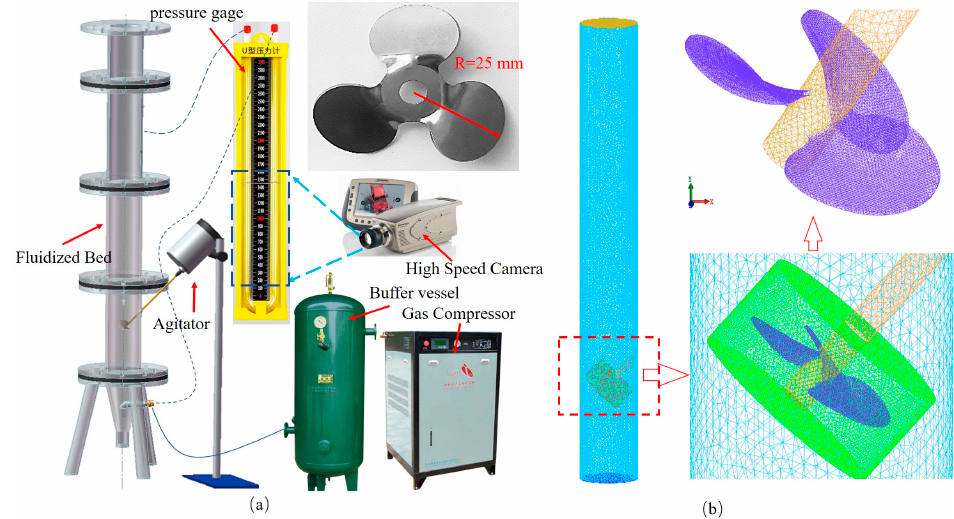
Figure 1. Experimental system and grid model. ( a ) Experimental system; ( b ) grid model.